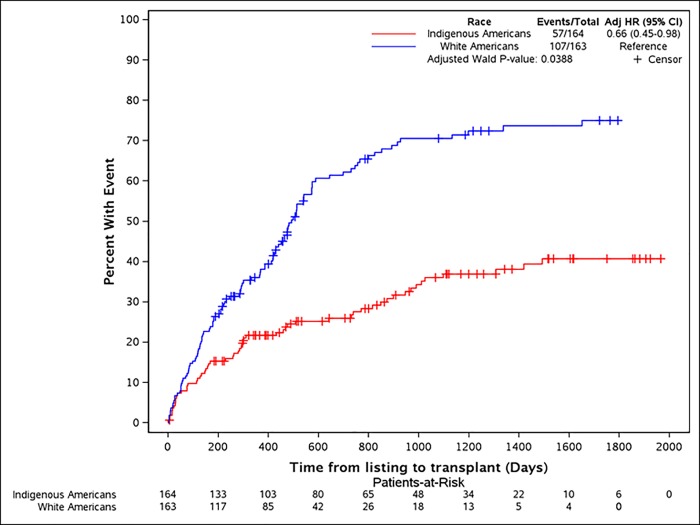
Incidence plot showing the inferior incidence of kidney transplants for the Indigenous Americans compared to whites.